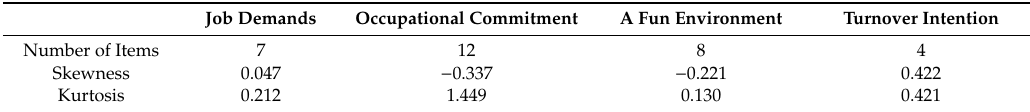
Table 2. Results of the Normality